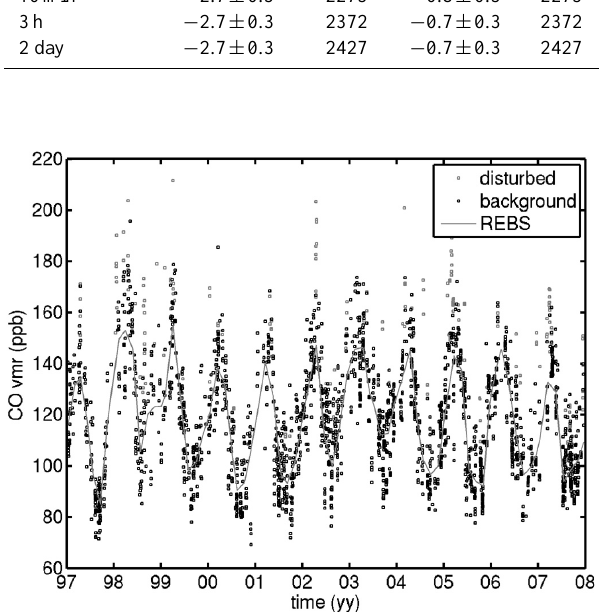
Fig. 5. Time series of FTIR CO concentrations (in ppb) at Jungfrau- joch. Background data determined by REBS-CNR filtering are shown in black. The curve of the REBS-CNR fit is shown in